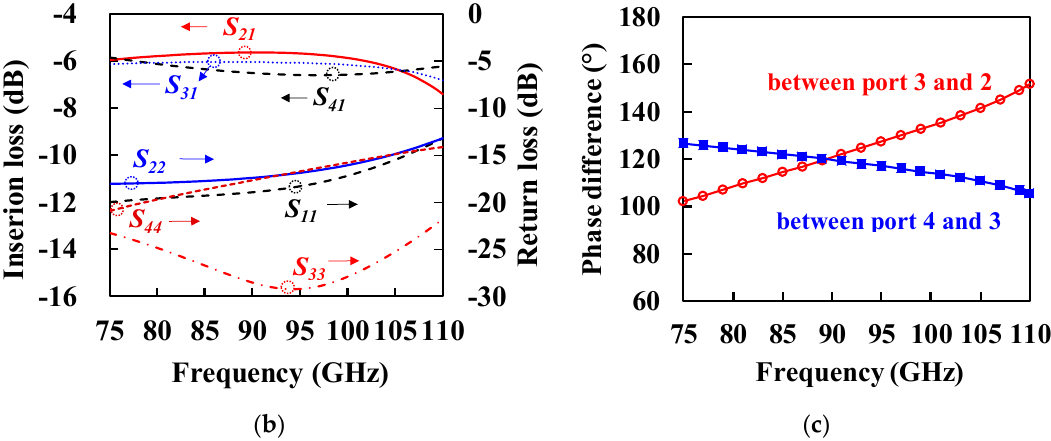
Figure 2. Designed 120° 3-way power divider. ( a ) Layout; ( b ) simulated insertion and return loss; ( c ) simulated phase difference between output ports.